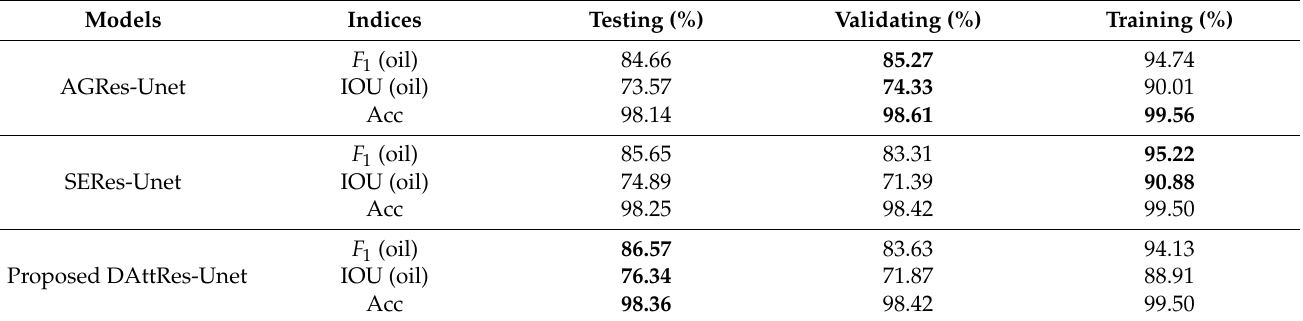
Table 3. Performance indices of AGRes-Unet, SERes-Unet, and the proposed DAttRes-Unet on testing, validating, and training data.